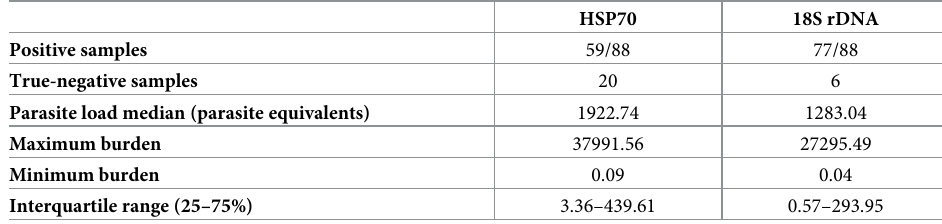
Table 4. Parasite loads in ATL clinical samples using qPCR assays targeting HSP70 and 18S rDNA.